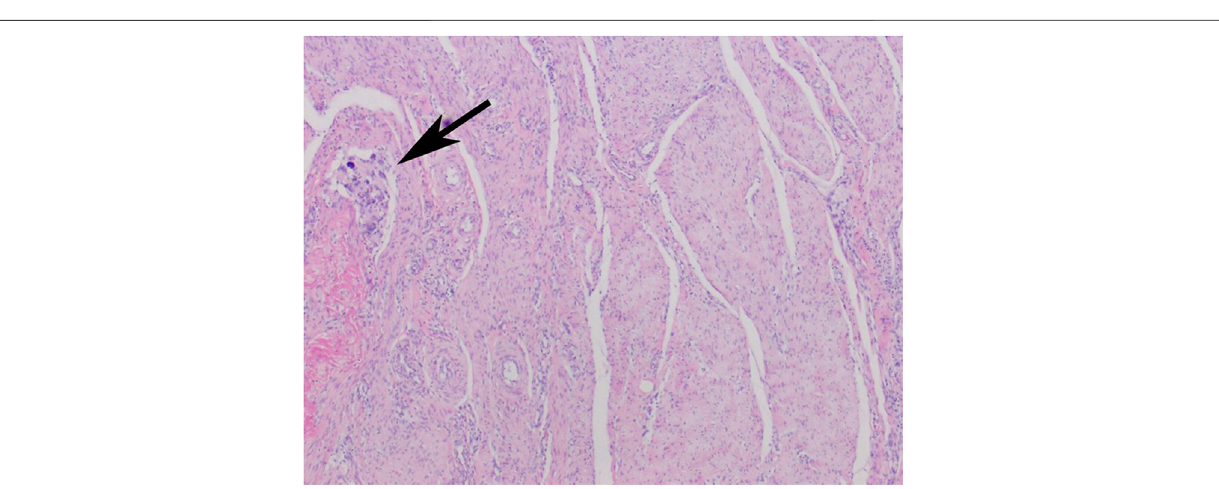
Frontiers in Bioengineering and Biotechnology |